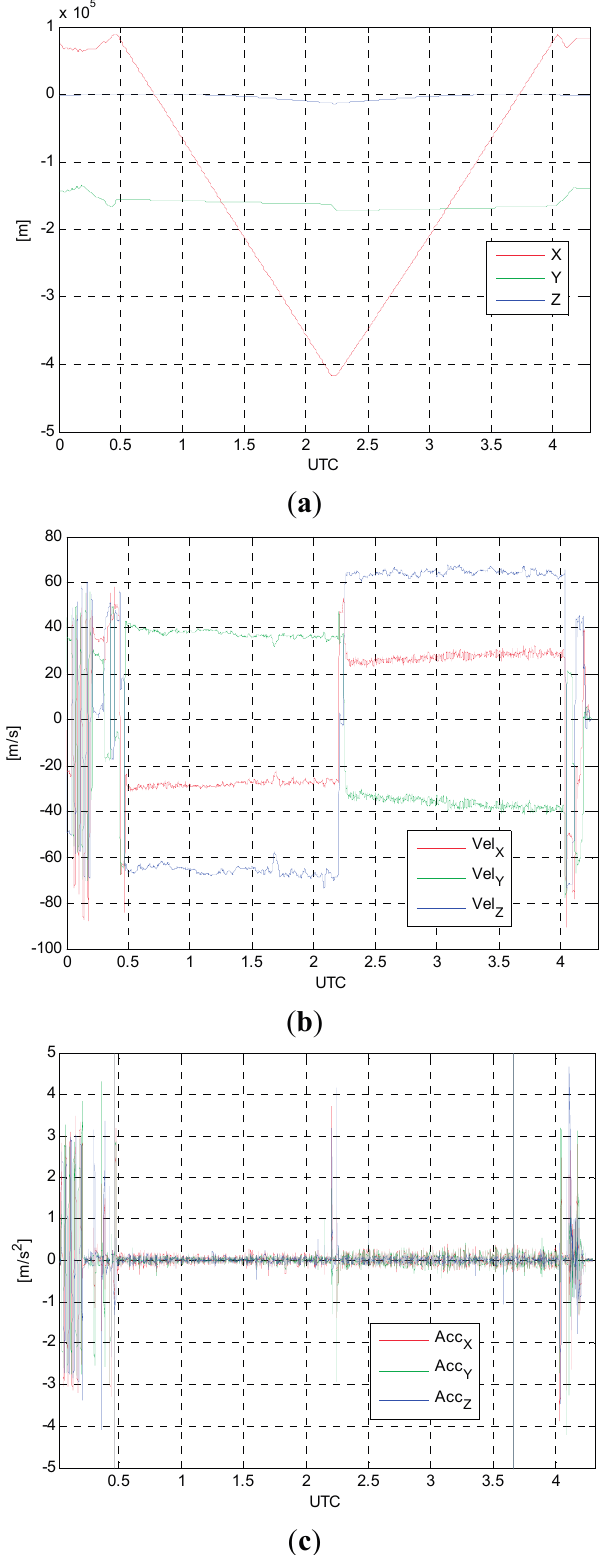
Figure 3. ( a ) Positions; ( b ) velocities; ( c )